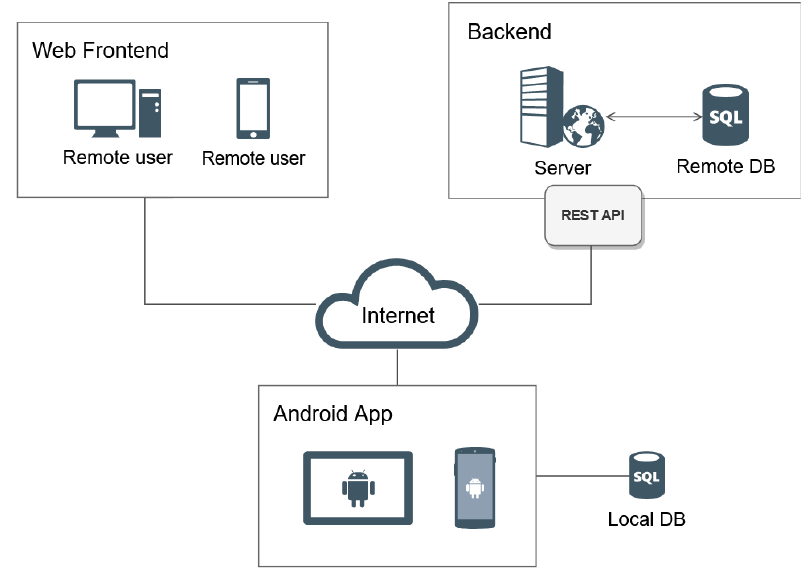
Figure 1. Overview of the system